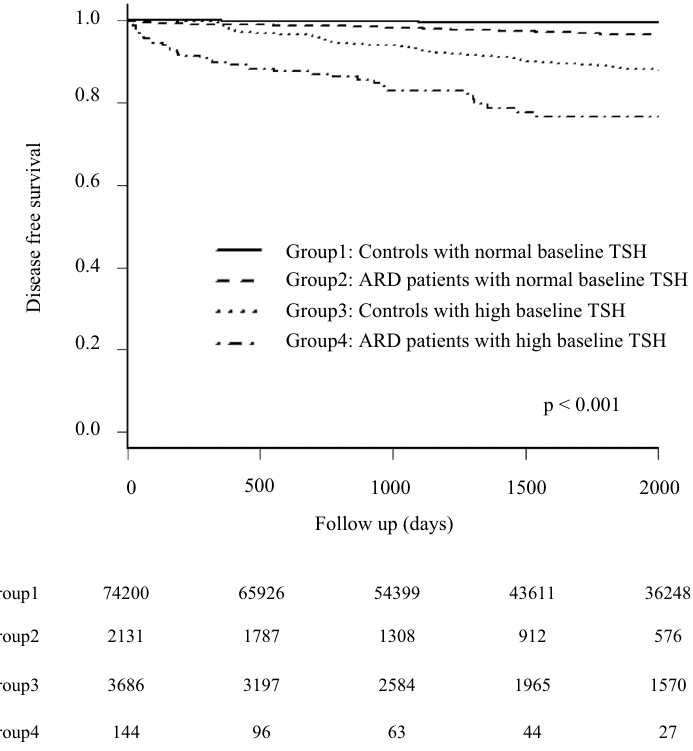
Figure 1. Age- and sex-adjusted disease-free survival of hypothyroidism requiring treatment in rheumatic disease patients and controls without treatment indication for hypothyroidism at baseline. ARD autoimmune rheumatic disease. TSH thyroid-stimulating